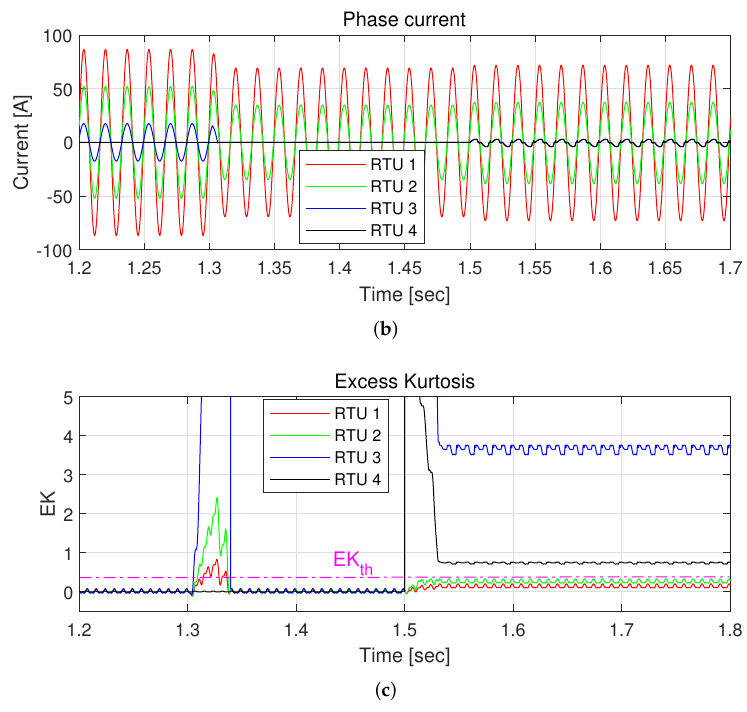
Figure 11. Phase currents and excess kurtosis indices. ( a ) Phase current. ( b ) Phase current (zoomed in x-axis). ( c ) Excess kurtosis.